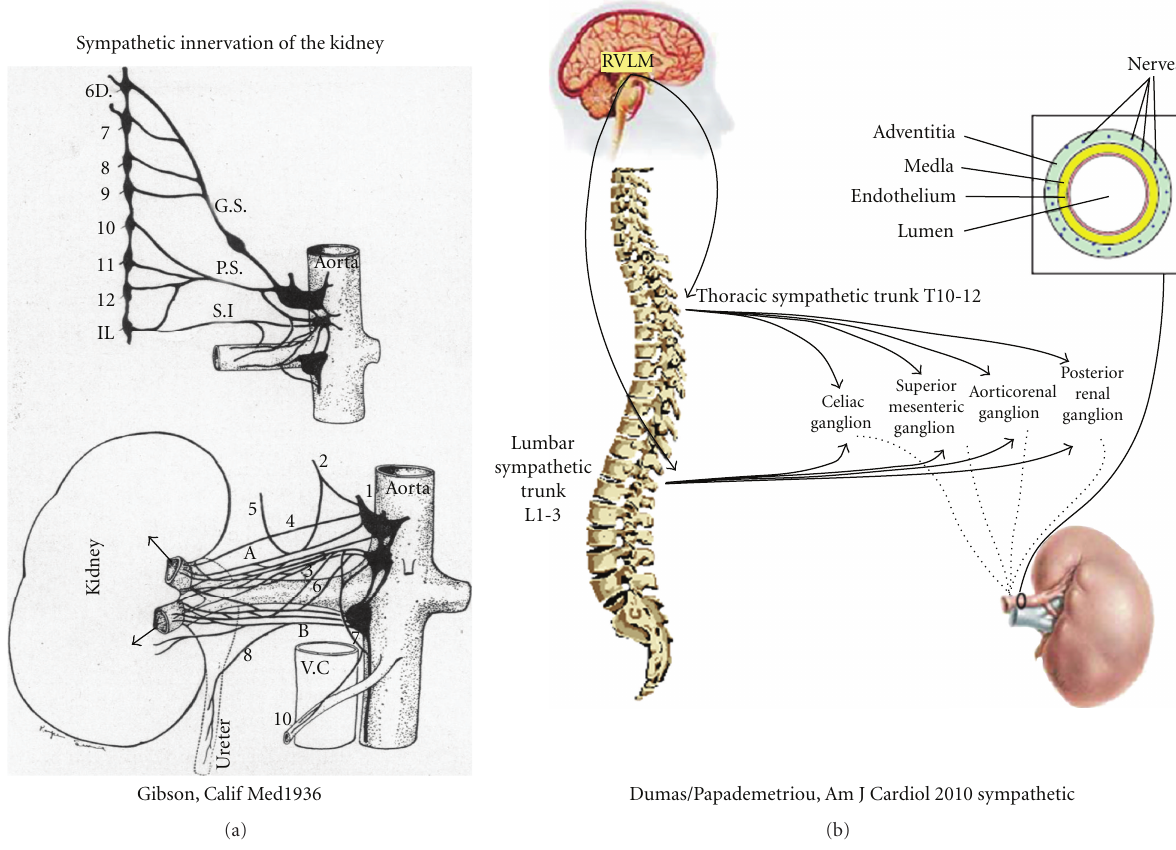
Figure 5: Schematic representation of sympathetic innervations of the